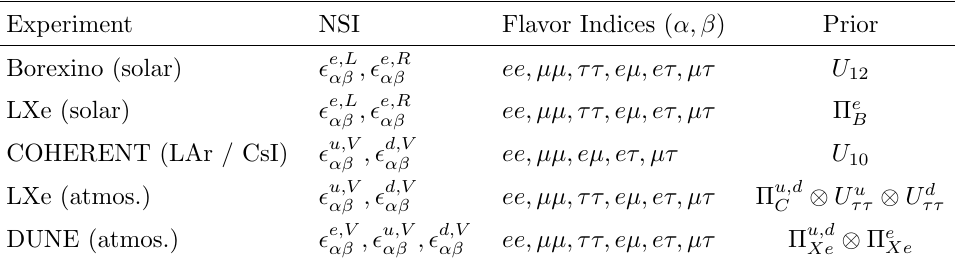
Table 1 . NSI parameters used in this analysis and the prior scheme used for each experiment. Here U N are N -dimensional uniform priors on the NSI vector of length N , chosen to range from 0 : 5 to 0 : 5. (cid:5) e , (cid:5) u;d , and (cid:5) u;d are the priors taken from the posterior distributions at Borexino, B C Xe (cid:0) COHERENT, and a future LXe DMD,